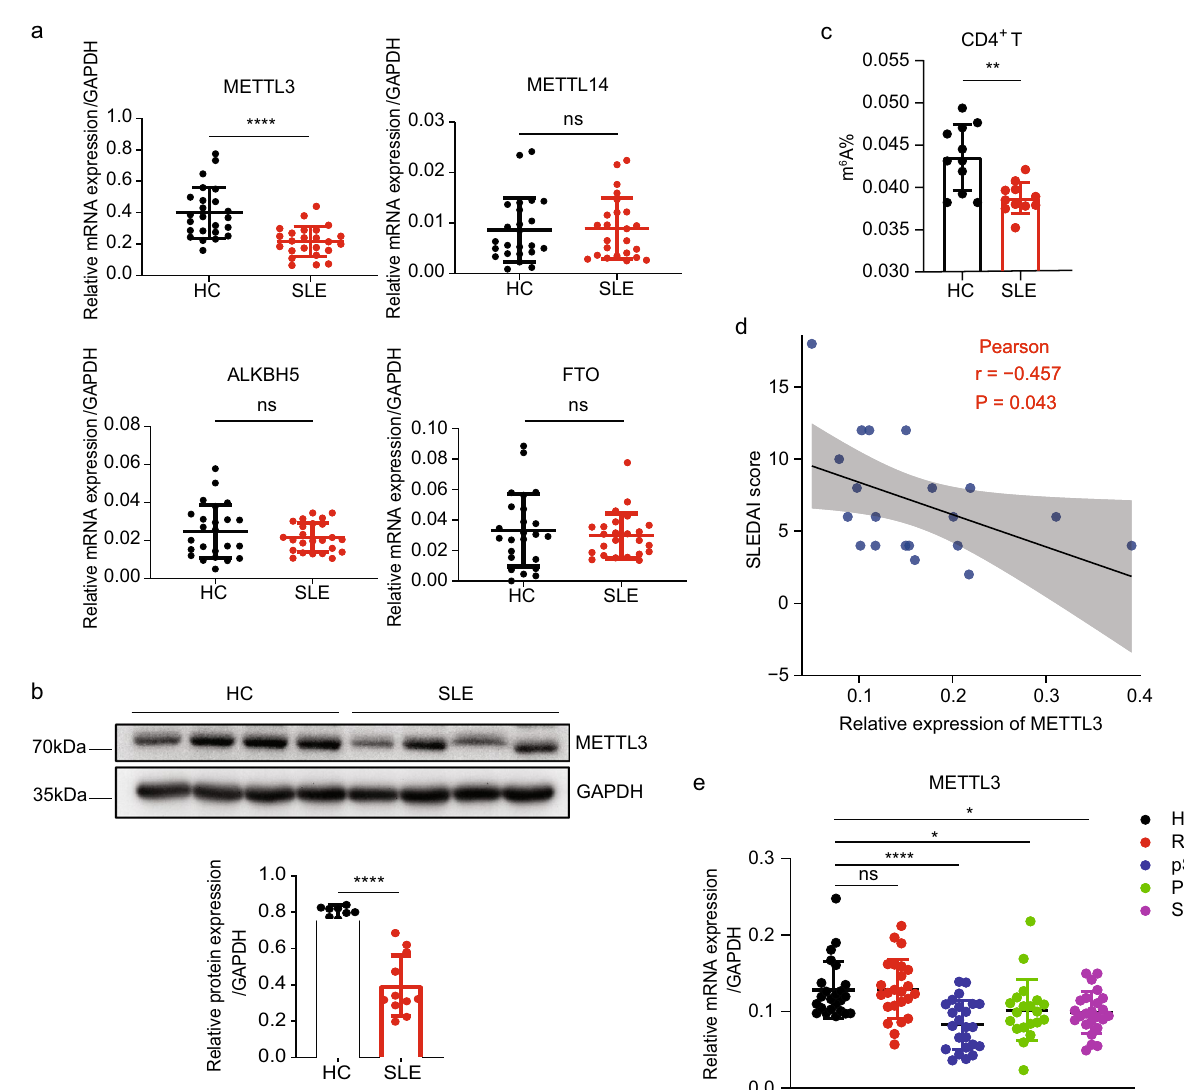
Fig. 1 METTL3 expression is significantly reduced in SLE CD4 + T cells compared with healthy controls (HCs). a Quantitative reverse transcription polymerase chain reaction (RT-qPCR) of the mRNA expression of METTL3, METTL14, ALKBH5, and FTO in SLE CD4 + T cells relative to HCs, n b Top: METTL3 protein levels in CD4 + T cells of SLE patients and HCs were detected by Western blot analysis, and GAPDH was used as a loading control; bottom: quantification of METTL3 protein levels, n 11. c Global m 6 A modification level in CD4 + T cells was determined by m 6 A = colorimetric quantification in SLE patients compared with HCs, n 11. d Correlation between the SLEDAI score and mRNA expression of METTL3 = in SLE CD4 + T cells, n 20. e RT-qPCR of METTL3 expression in rheumatoid arthritis (RA), primary Sjogren’s Syndrome (pSS), psoriasis (PS), and SLE = compared with HCs, n 24. (* p < 0.05, ** p < 0.01, **** p < 0.0001, ns, no significance, unpaired two-tailed Student’s t test for a – c , Pearson’s correlation = analysis for d , one-way ANOVA with Dunnett’s multiple comparisons test for e